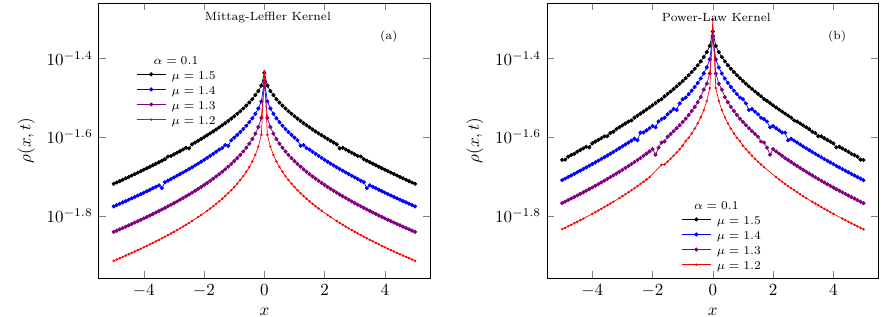
= 10 2 , and different K